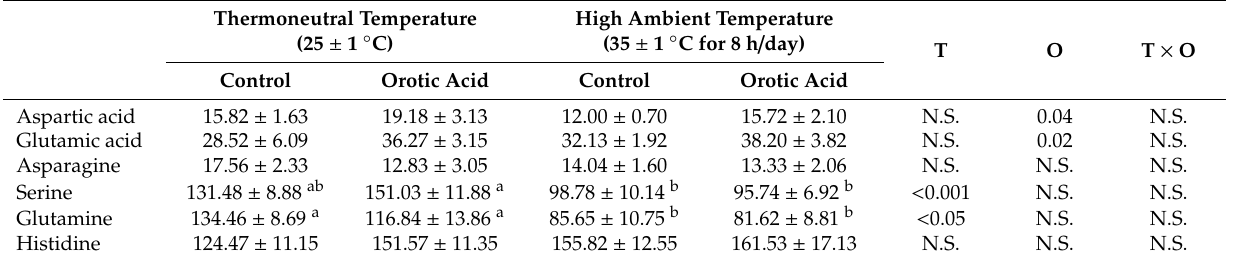
Table 3. E ff ects of a cyclic high ambient temperature and feeding orotic acid on plasma-free amino acids of broiler chickens ( µ